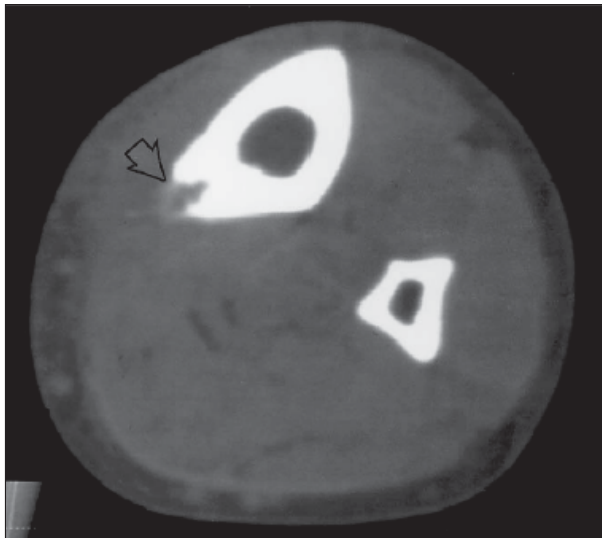
Figure 1) Computed tomography of a patient with Pasteurella multo- cida osteomyelitis of the left tibia. Arrow indicates ill-defined permea- tive changes and a soft tissue mass